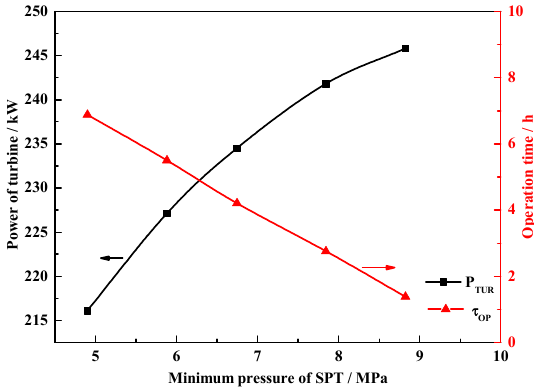
Figure 9. Effect of SPT minimum pressure on P TUR and operation time.